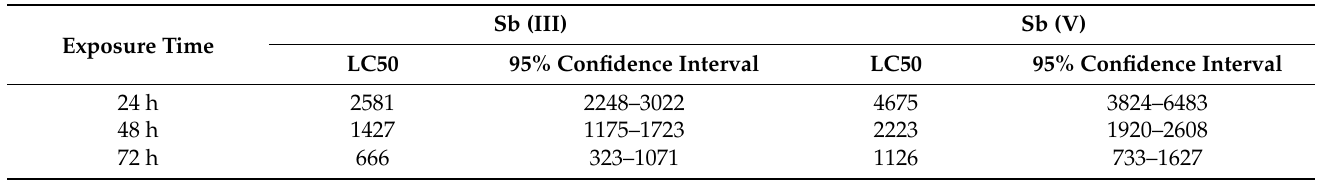
Table 2. LC50 (mg/L, 95% confidence intervals) of Sb (III) and Sb (V) to E. fetida in acute contact toxic test.